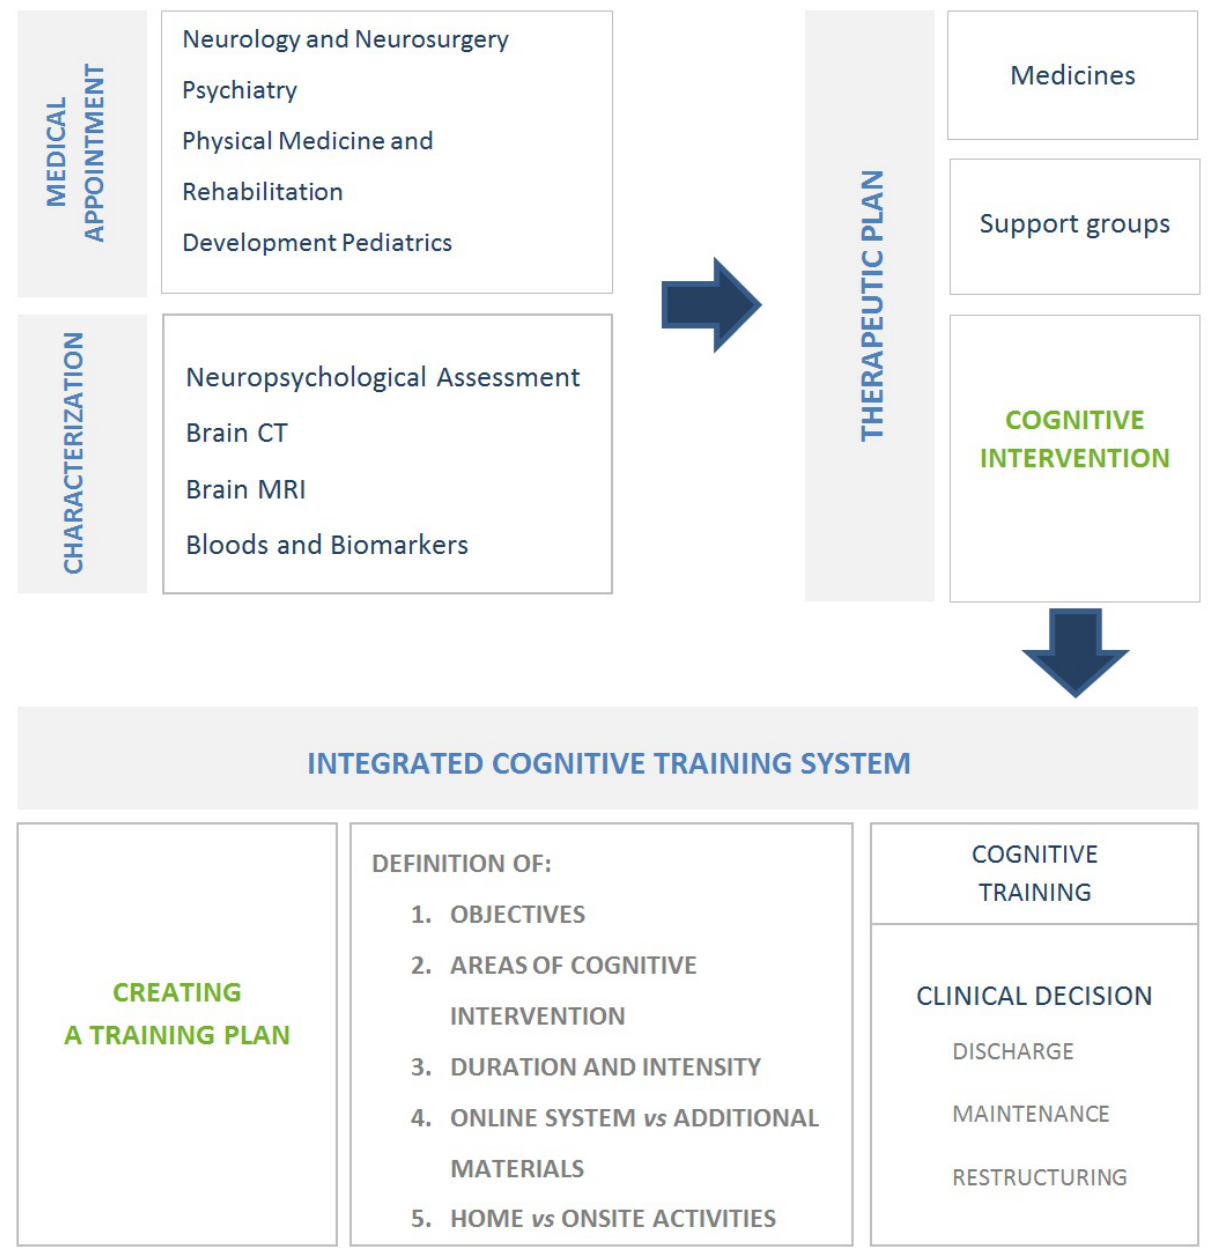
Figure 1. Clinical context in which COGWEB was